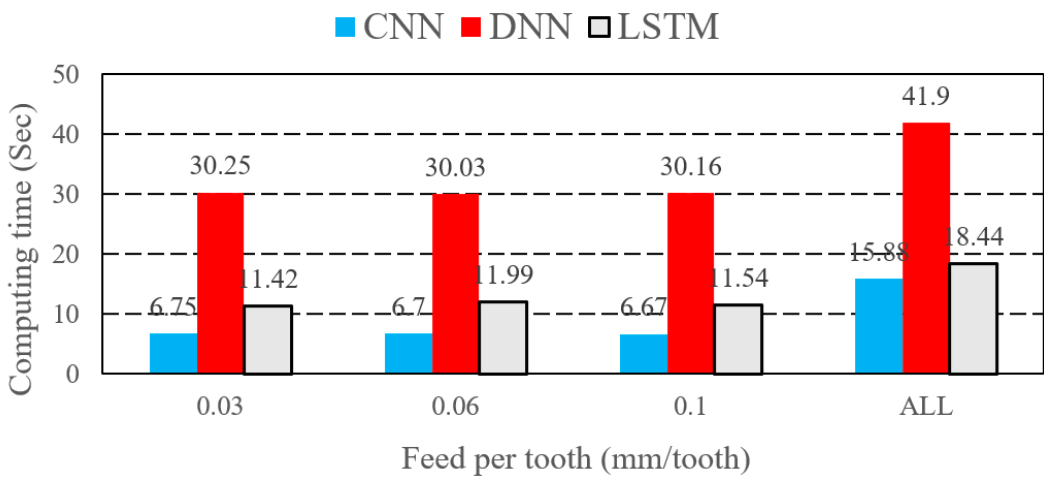
Figure 16. Comparison of computing time between models.